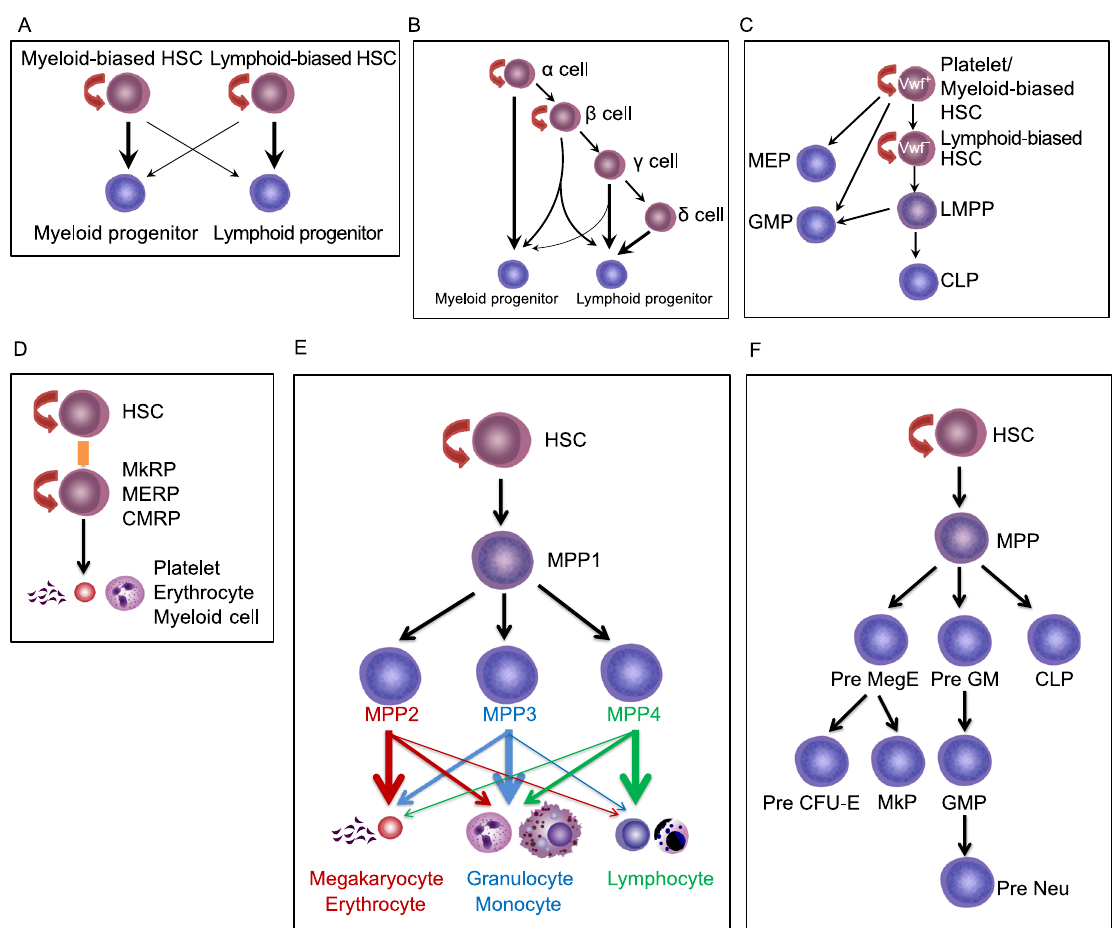
Figure 2. The revised models for hematopoietic stem cell differentiation. (A) My-Bi and Ly-Bi HSCs model. Ly-Bi HSCs reconstitute the myeloid lineage to a lesser extent than the lymphoid lineage, and vice versa. (B) Eaves ’ lab de fi ned α , β , γ , and δ cells according to the percentage of myeloid chimerism relative to that of lymphoid chimerism (M/L ratio). Single donor cell is de fi ned as α cells when the M/L ratio exceeds 2, β cells when M/L ratio exceeds 0.25 but is less than 2, and γ / δ cells when it is less than 0.25. Therefore, α cells are myeloid-biased, β cells are balanced, and γ / δ cells are lymphoid-biased without 2nd transplantation capability. (C) vWF + platelet-biased HSCs sit at the apex of the hierarchy, and can differentiate into all progenitors and mature cells. vWF − lymphoid-biased HSCs reside downstream of vWF + HSCs. LMPPs cannot give rise to the megakaryocyte/erythrocyte lineage. MEPs are directly derived from HSCs. (D) In the myeloid bypass model, the LT-HSC population contains CMRPs, MERPs, and MkRPs. These MyRPs are directly produced by HSCs. (E) MPP subtypes are separated into MPP1 – 4. MPP1 can give rise to all lineages. MPP2/3 are myeloid-biased and MPP4 is lymphoid-biased. In addition, MPP2 is platelet-biased. (F) In this model, MPPs differentiate into pre MegE, Pre GM and CLP. Pre MegE is upstream of MkP and pre CFU-E. Pre GM gives rise to GMP, and subsequently generates newly de fi ned neutrophil precursors (Pre